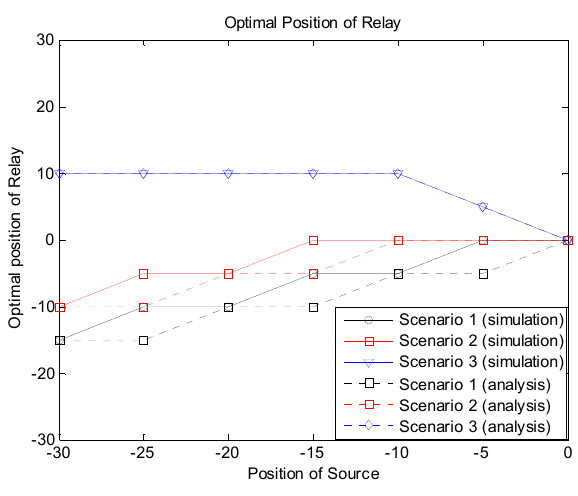
Figure 16. Optimal relay position.